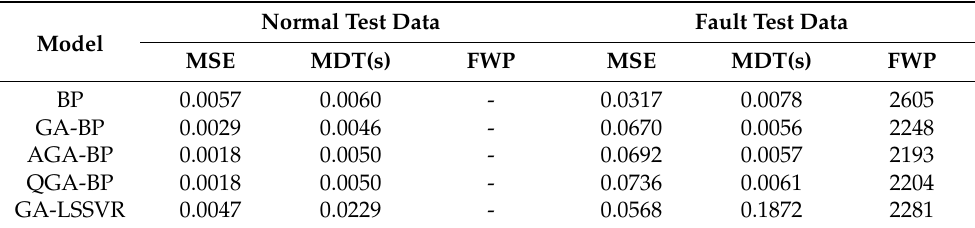
Table 1. BP, GA-BP, AGA-BP, QGA-BP, and GA-LSSVR fault detection